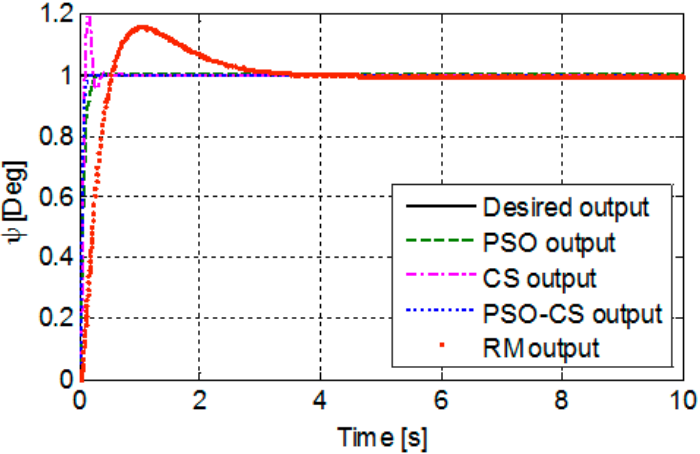
Figure 5. Quadrotor’s altitude z using Particle Swarm Optimization (PSO), Cuckoo Search (CS), Particle Swarm Optimization-Cuckoo Search (PSO-CS), and Reference Model (RM).